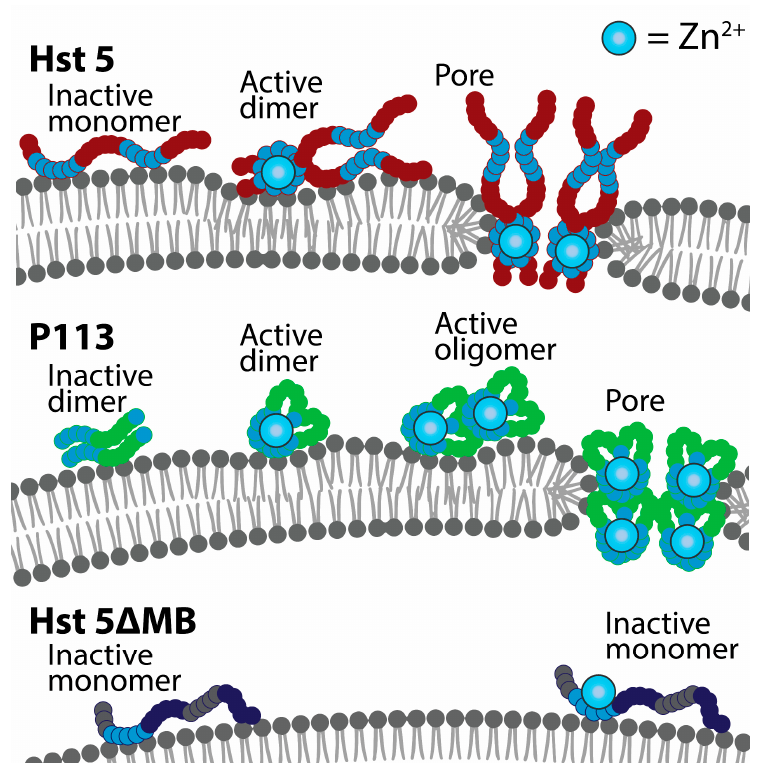
Figure 8. A model of Zn 2+ -induced pore formation by Hst 5 and P113. Zinc binding induces soluble dimers of Hst 5 that bind to the cell surface of C. albicans and C. glabrata . Interaction with fungal membranes induces dimer units to assemble into higher order structures, which induces membrane curvature and toroidal pores. P113 functions similarly but is dimeric before Zn 2+ binding and requires more assembly steps to form a pore structure of the same size as Hst 5. Hst 5 ∆ MB binds to zinc but does not form dimers or assemble into higher order structures when membrane bound.